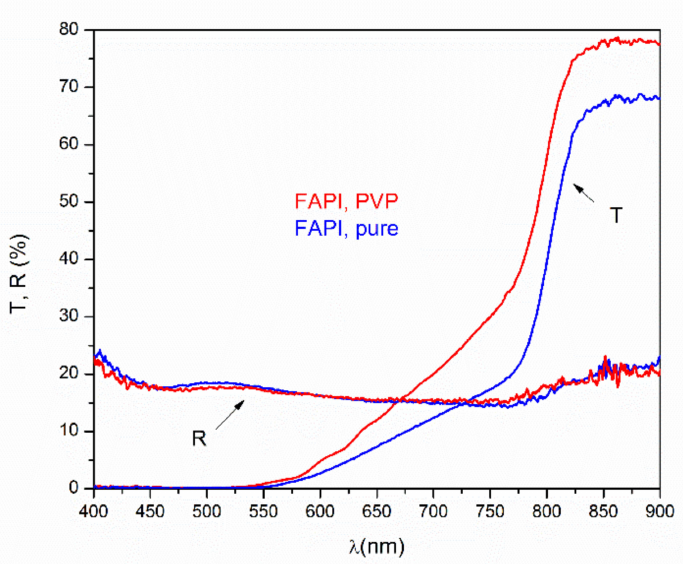
Figure 8. Transmittance and reflectance of FAPI perovskite with and without PVP.